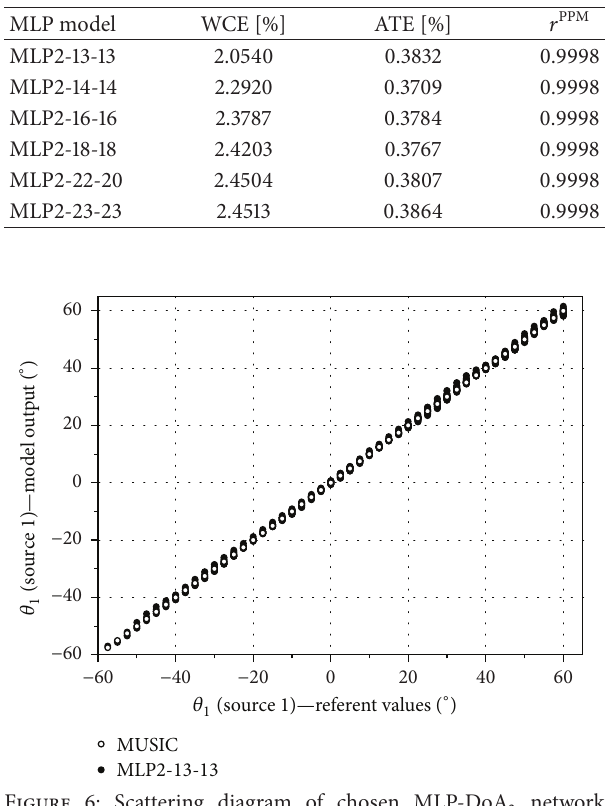
Figure 6: Scattering diagram of chosen MLP-DoA 2 network (MLP2-13-13)andtheMUSICmodelforoutput1(source1)obtained by simulation on the test set (Case 𝑠 = 2 ).